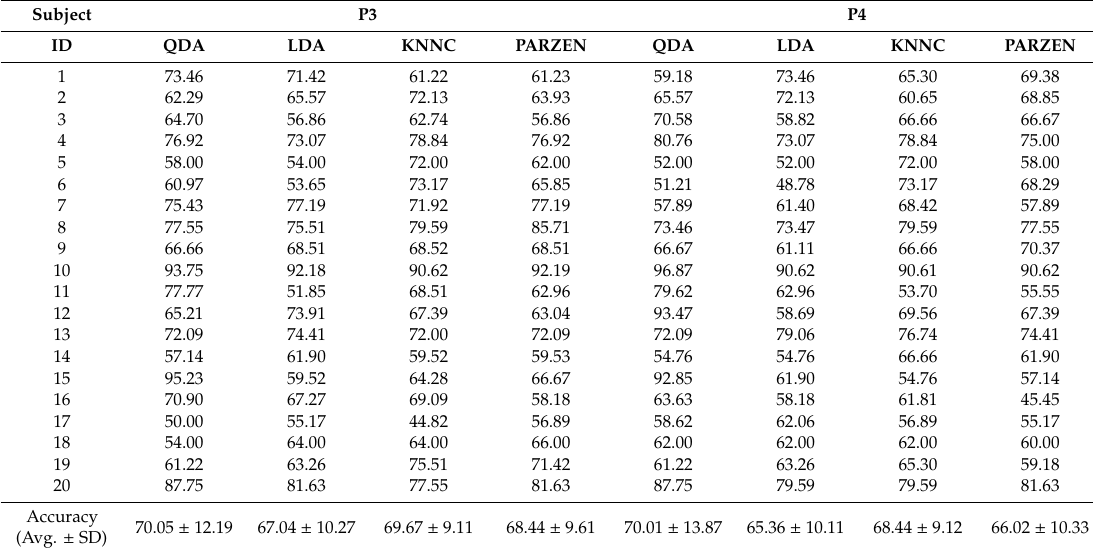
Table 4. Result of leave-one-out cross validation using the EEG frequency spectrum (1–50 Hz) as input in the machine learning approaches including QDA, LDA (parametric), KNNC and PARZEN (nonparametric). The performance of the classification system is compared in accuracy (%) during inter-subject and intra-subject variability in parietal lobe (P3 and P4) of the